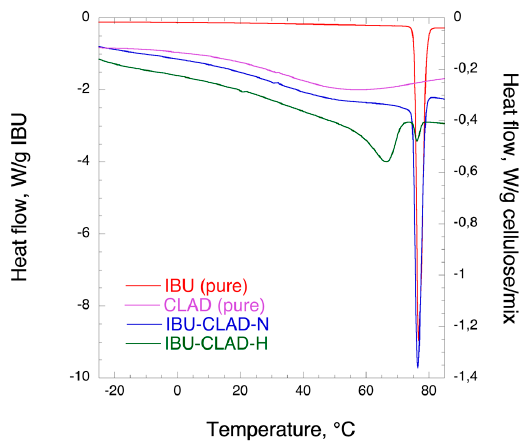
Figure 1. Di ff erential scanning calorimetry (DSC) results of IBU (pure), CLAD (pure), and studied 20% Figure 1. Differential scanning calorimetry ( DSC) results of IBU (pure), CLAD (pure), and studied 20% w / w IBU-CLAD-N (non-heated) and IBU-CLAD-H (heated) mixtures. w / w IBU-CLAD-N (non-heated) and IBU-CLAD-H (heated) mixtures.